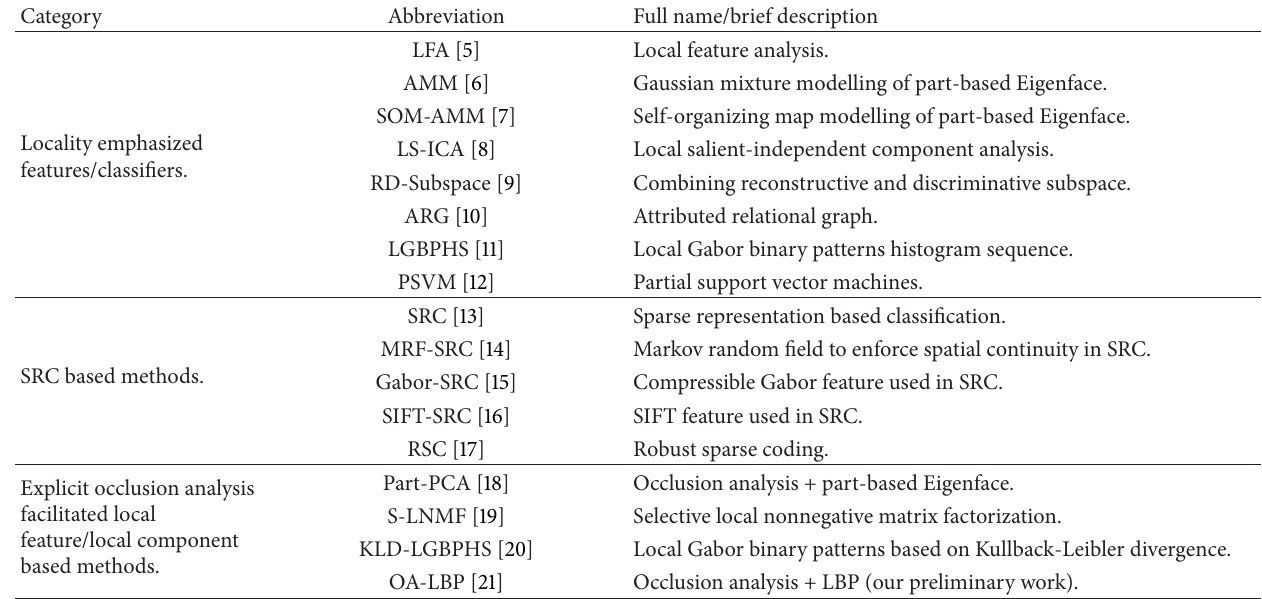
Table 1: Summary of literature works in occluded face